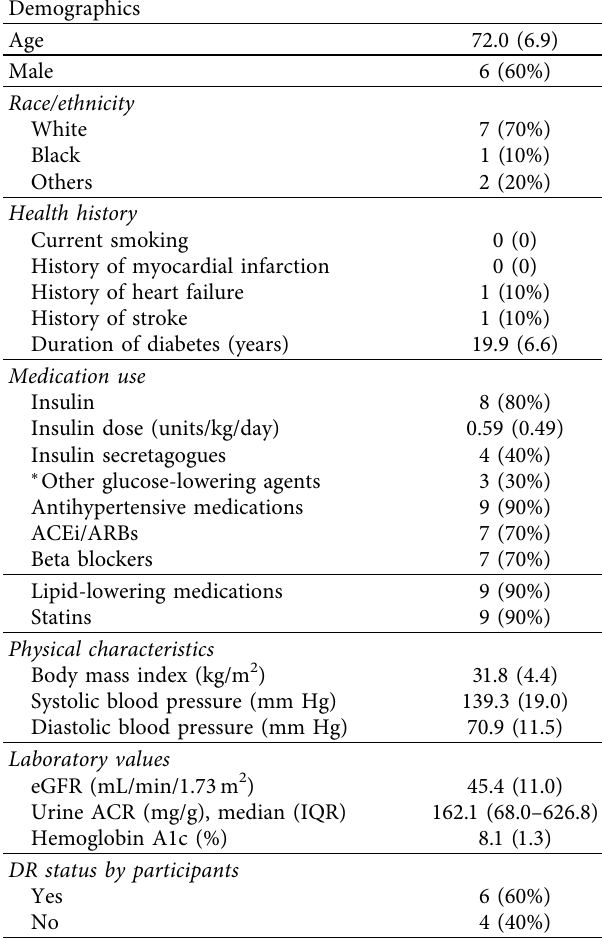
Table 1: Characteristics of ten participants in the continuous glucose monitoring to assess glycemia in chronic kidney disease study with successful retinal imaging by optical coherence to- mography